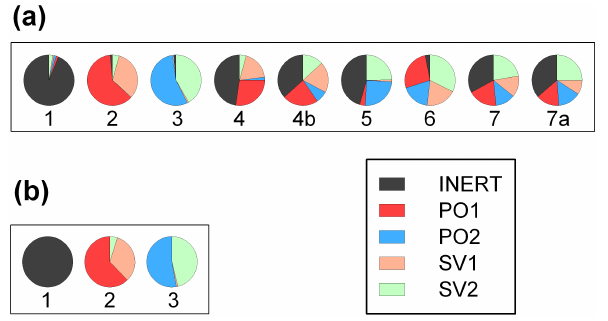
Fig. 4. Compositional plots for external mixture aerosol popula- tions formed at t =188 h in base case scenario simulations. (a) with coagulation, (b) without